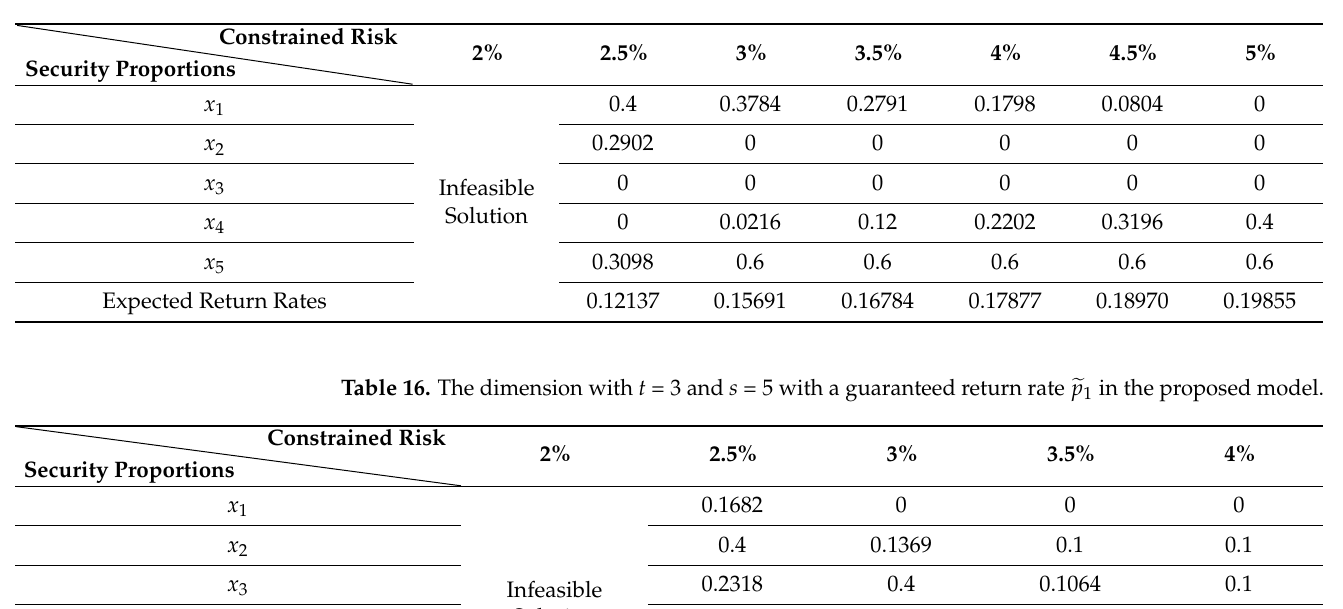
Table 15. The dimension with t = 2 and s = 3 with a guaranteed return rate (cid:101) p 3 in the proposed model.